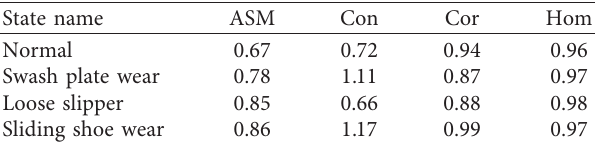
Table 6: Classification accuracy rate of symmetrical polar coor- dinate combined with GLCM.